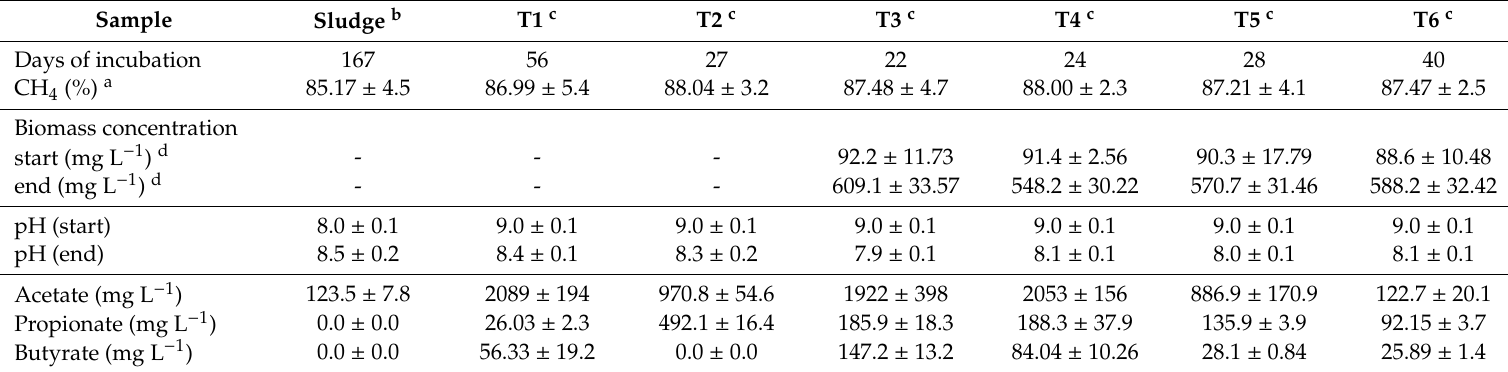
Table 1. Summary of process parameters during the enrichment in the first stage with sludge and in the second stage with six culture transfers (T1–T6).